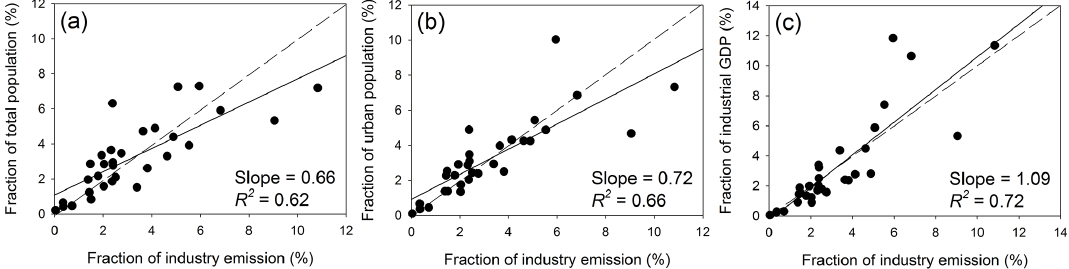
Figure 3. Correlations between normalized provincial industrial emissions and three types of spatial proxies: (a) total population, (b) urban population, and (c) IGDP